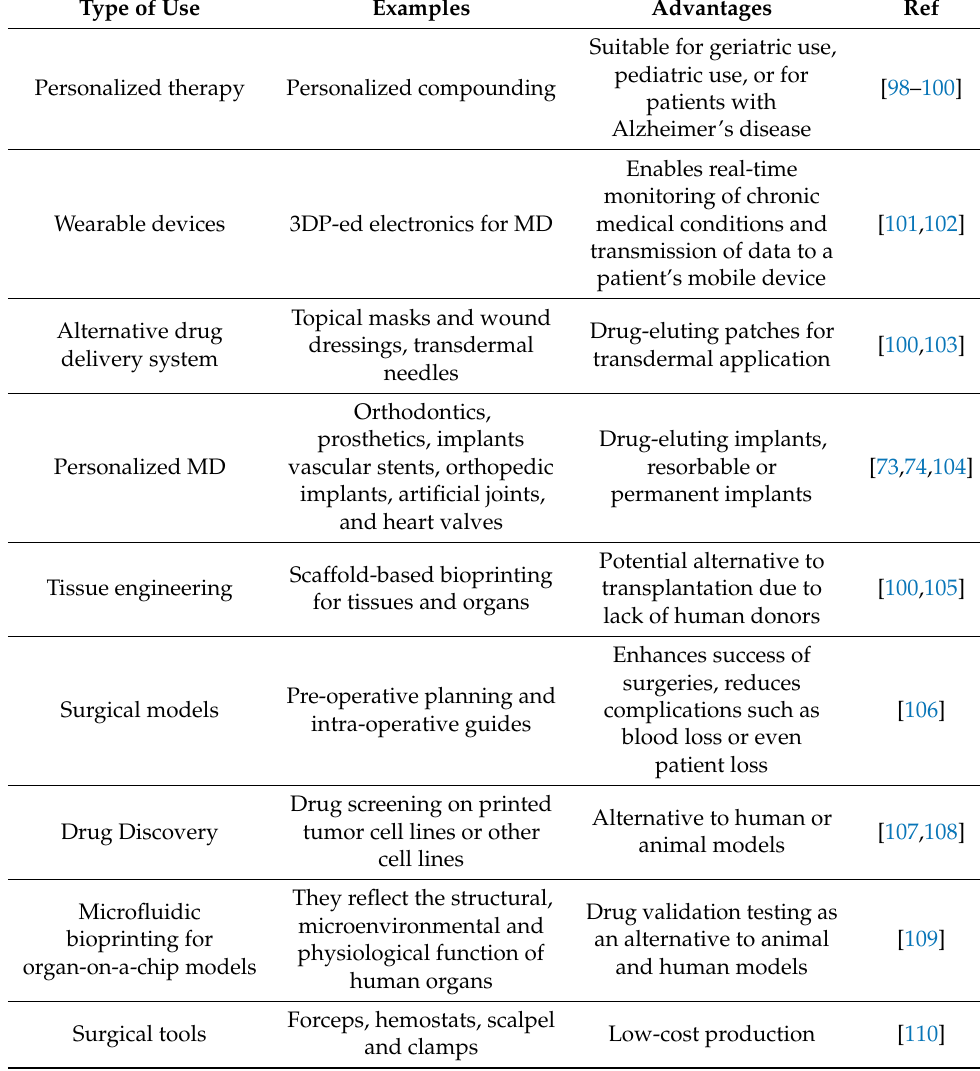
Table 1. Application of 3D printed Medical